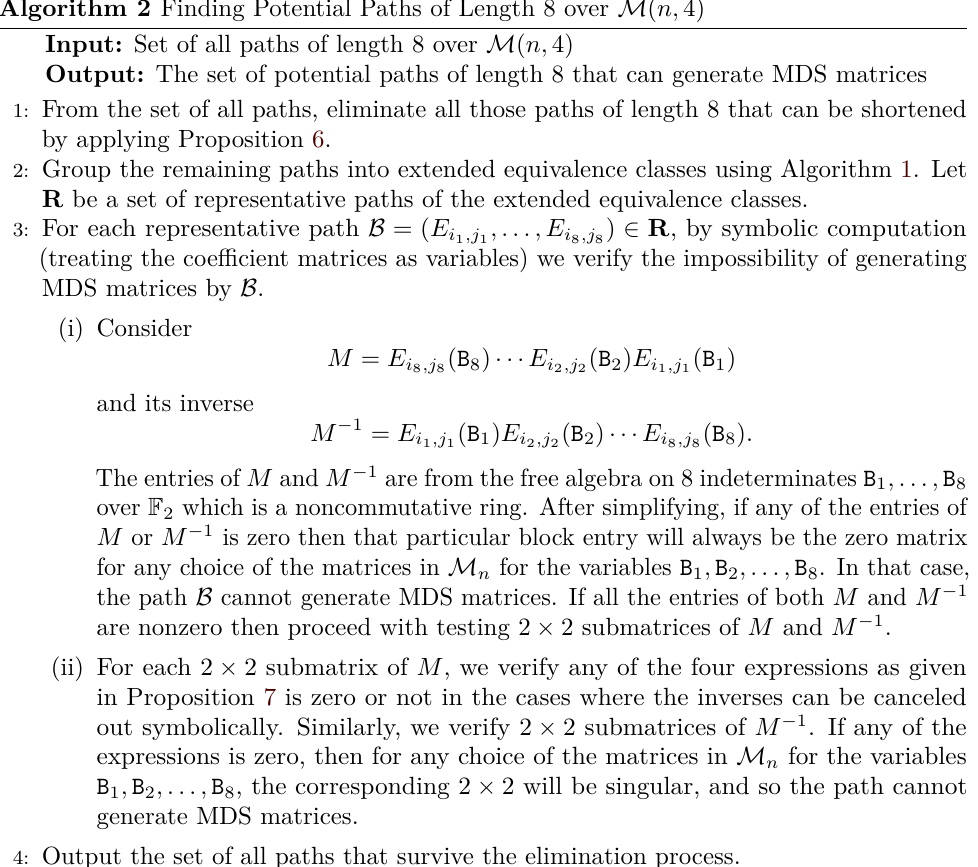
Algorithm 2 Finding Potential Paths of Length 8 over M ( n, 4)